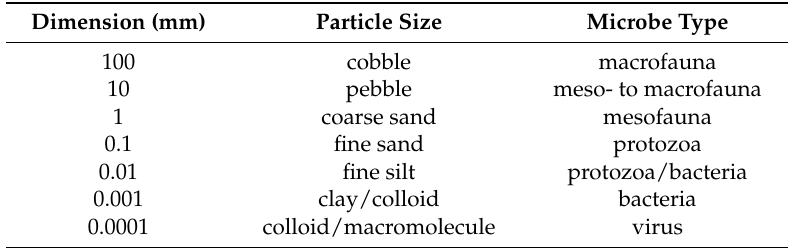
Table 1. Comparative size scale of particles, infauna, and microbial